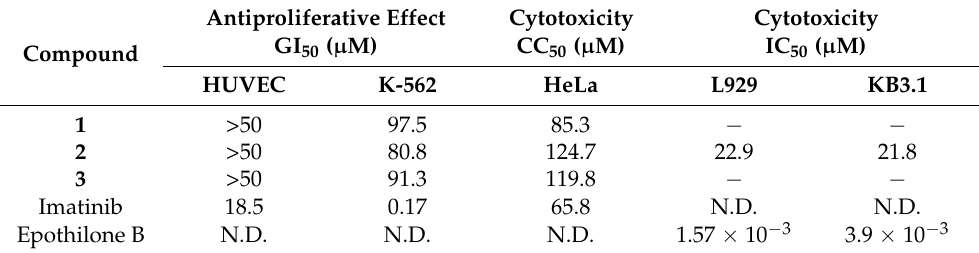
(DSM PA14), Staphylococcus aureus (DSM 346) and Mycobacterium tuberculosis H 37 Rv. Table 2. Antiproliferative and cytotoxicity of compounds 1–3 against mammalian cancer cell lines.